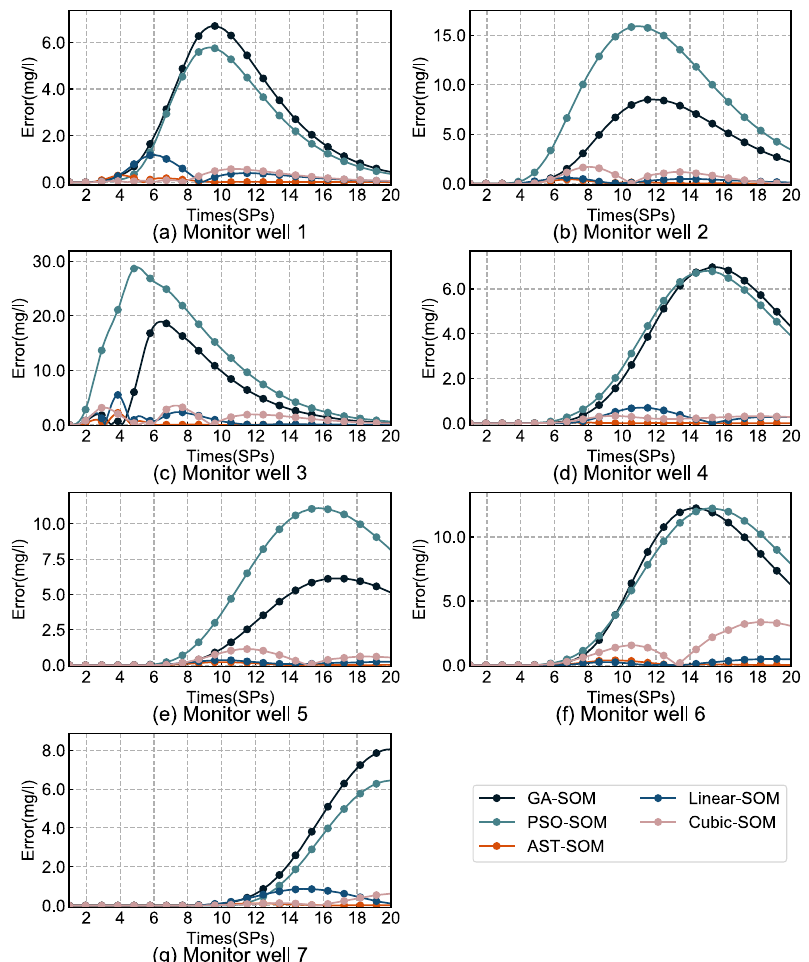
Figure 11. The errors between observed and simulated values corresponding to the best optimization results of five methods.